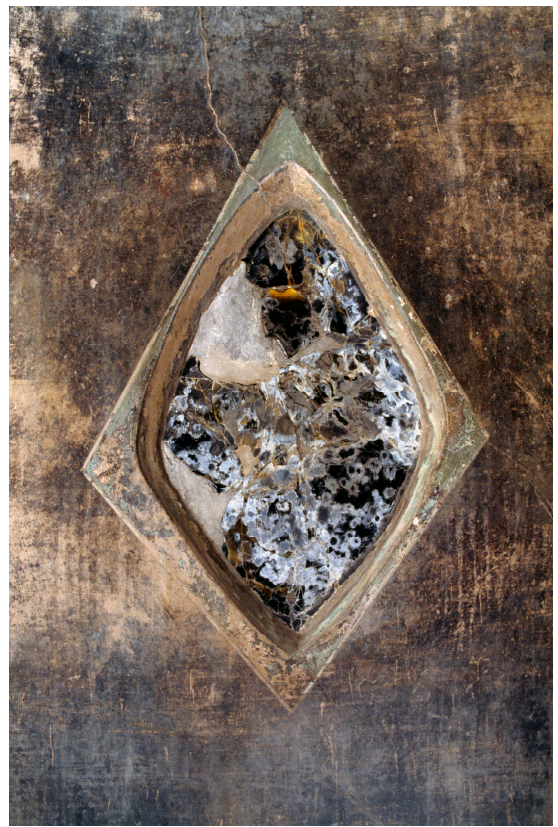
Figure 3. Inset Obsidian, House of the Gilded Cupids, Pompeii. De Agnostini Picture Library/Archivo J. Lange/Bridgeman Images. Used by Permission.